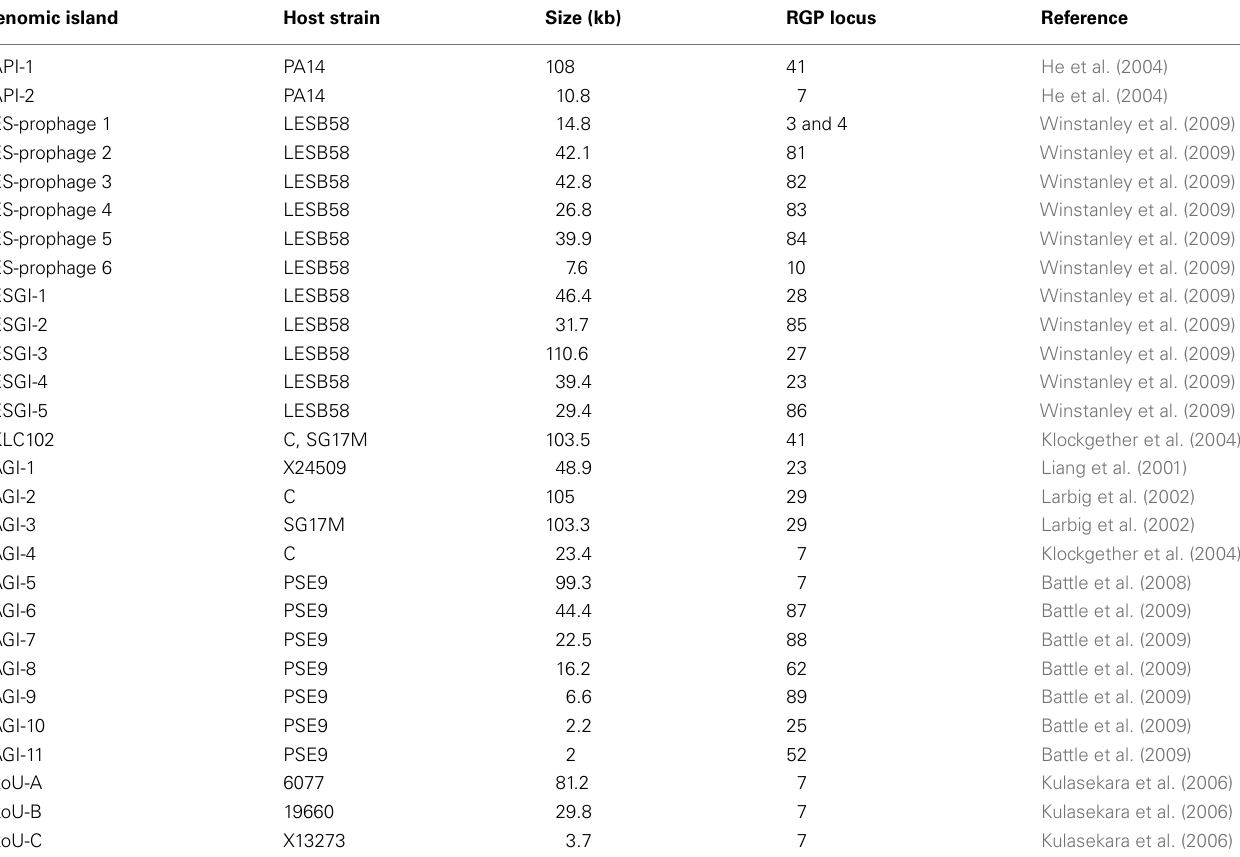
Table 3 | Genomic islands in P. aeruginosa strains described in